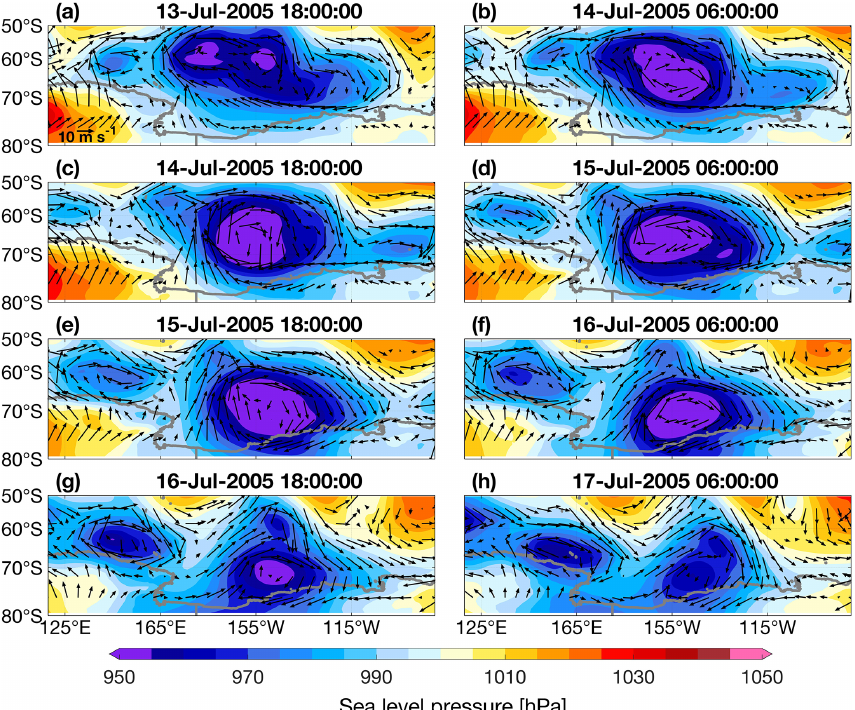
Figure 4. (a–h) Spatial distributions of 12h average sea level pressure (colored shading) and 10m wind vectors (black arrows) in the Ross Sea and surrounding regions over 13–17 July 2005.